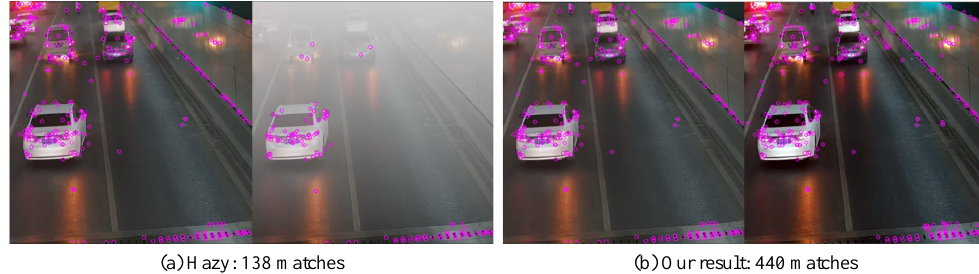
Figure 10. Local keypoints matching by applying the SIFT operator. Compared with the hazy images, the matching results shown that the proposed method can improved the quality of inputs significantly.